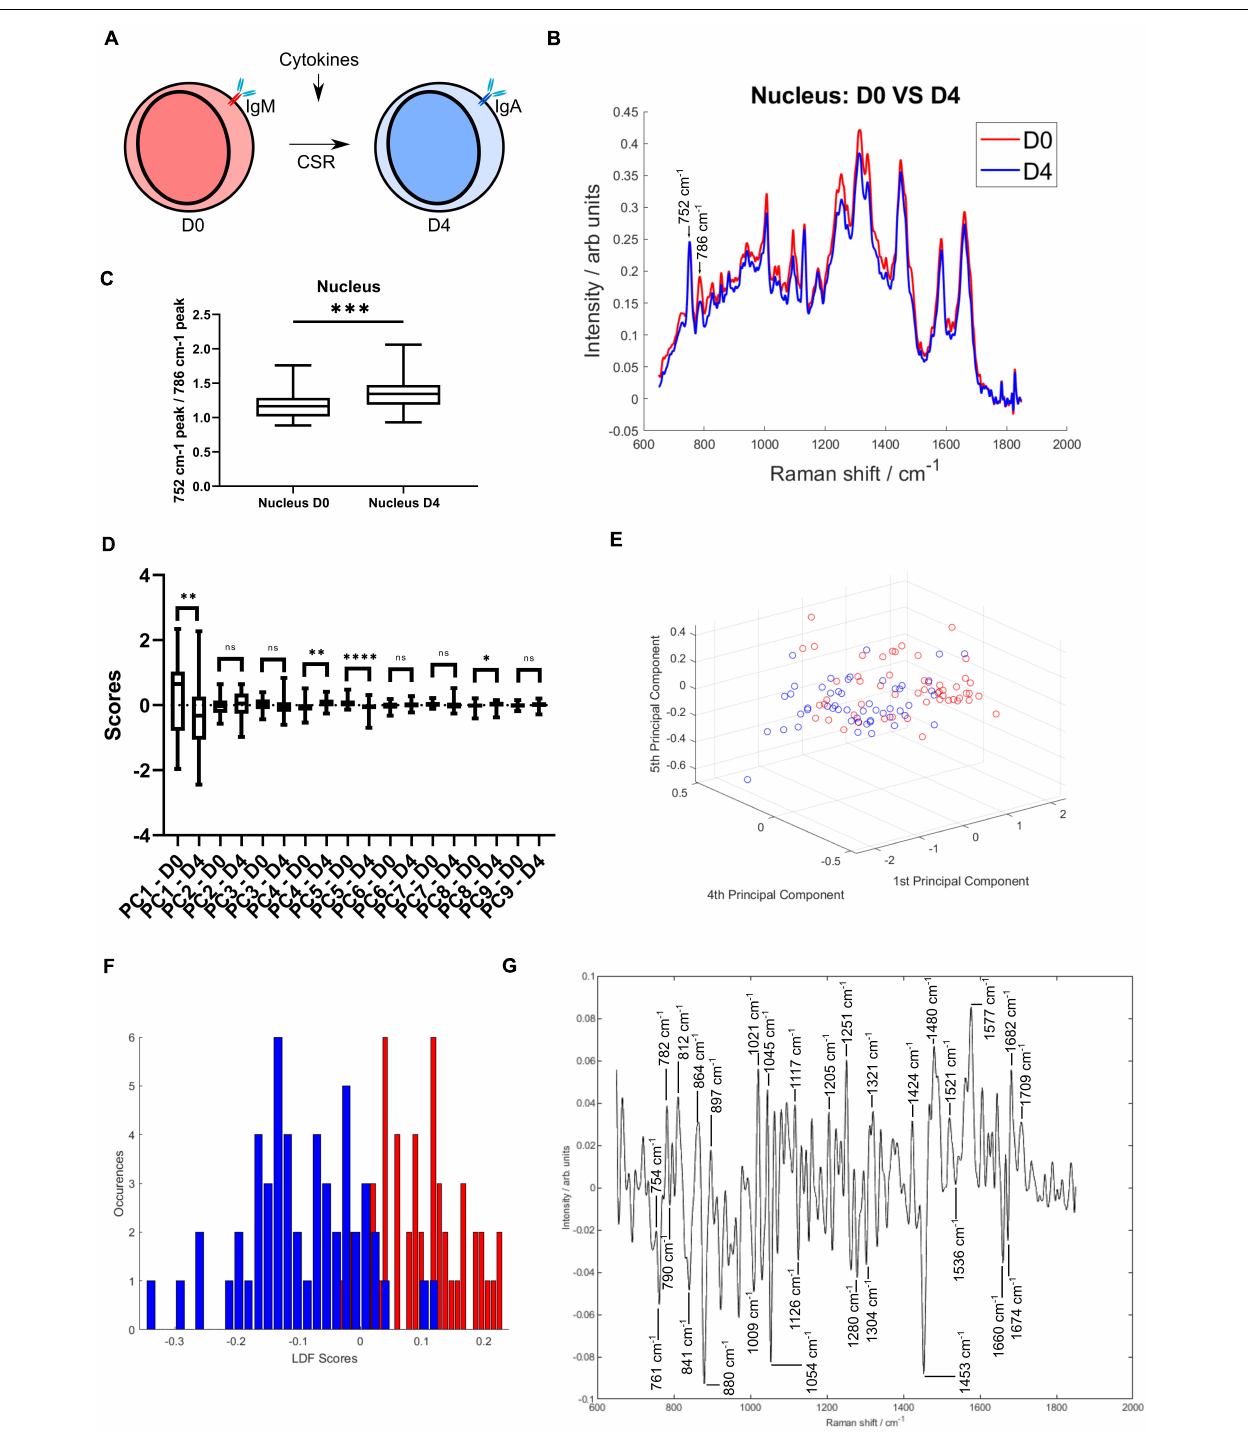
FIGURE 2 | Quantifiable spectral differences between D0 and D4 cells. (A) Schematic representation of a CH12F3 cell undergoing class switch recombination in response to exposure to the cytokine cocktail. The expressed B cell receptor constant region changes from IgM to IgA. (B) The mean nucleus spectrum of D0 and D4 cells. Two neighboring peaks are highlighted. (C) Peak ratio (752/786 cm − 1 peak). A t -test gave a statistically significant difference between samples ( ns P > 0.05, ∗ P < 0.05, ∗∗ P < 0.01, ∗∗∗ P < 0.001, ∗∗∗∗ P < 0.0001). (D) Principal Component analysis. Comparison of the first 9 PC scores. A t -test was applied to identify the principal components with a statistically significant difference between D0 and D4. (E) PCA analysis. Scores plotted for components 1, 4, and 5. (F) LDA analysis. Histogram of the distribution in the training model. (G) LDA analysis. Loading spectrum.